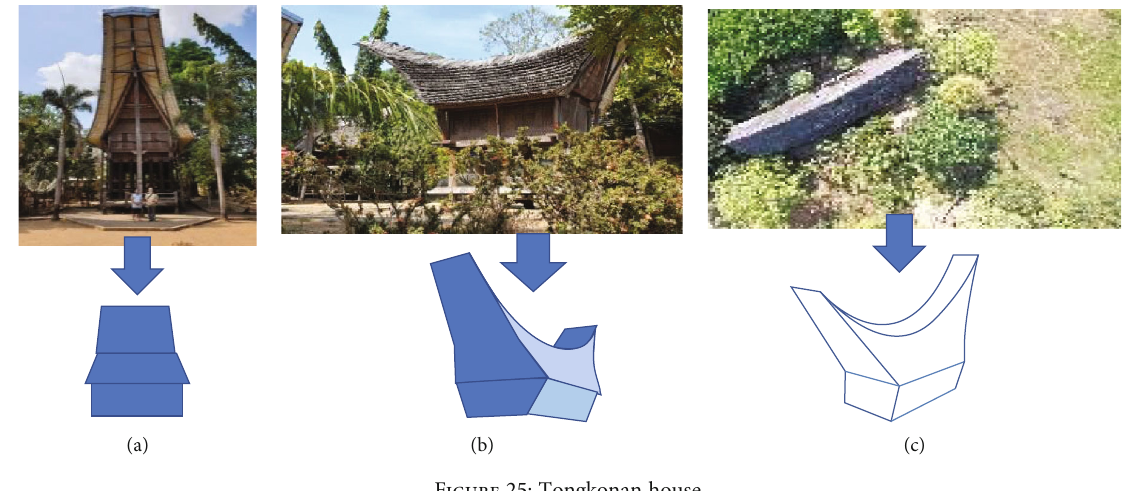
Figure 25: Tongkonan house.